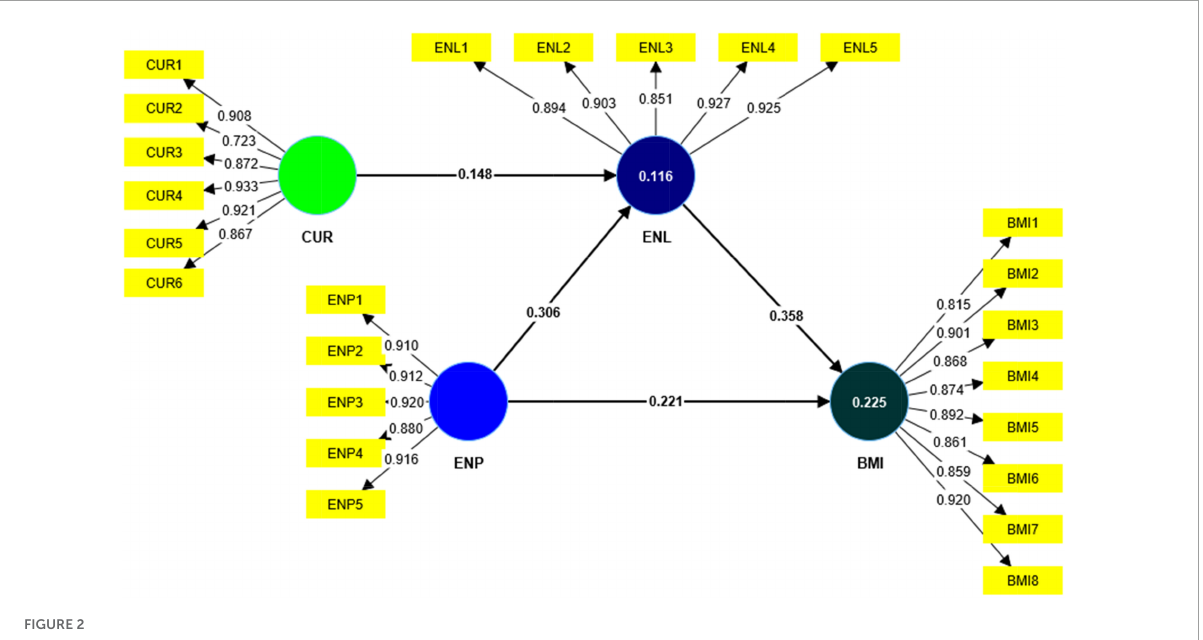
FIGURE2 Measurement model.